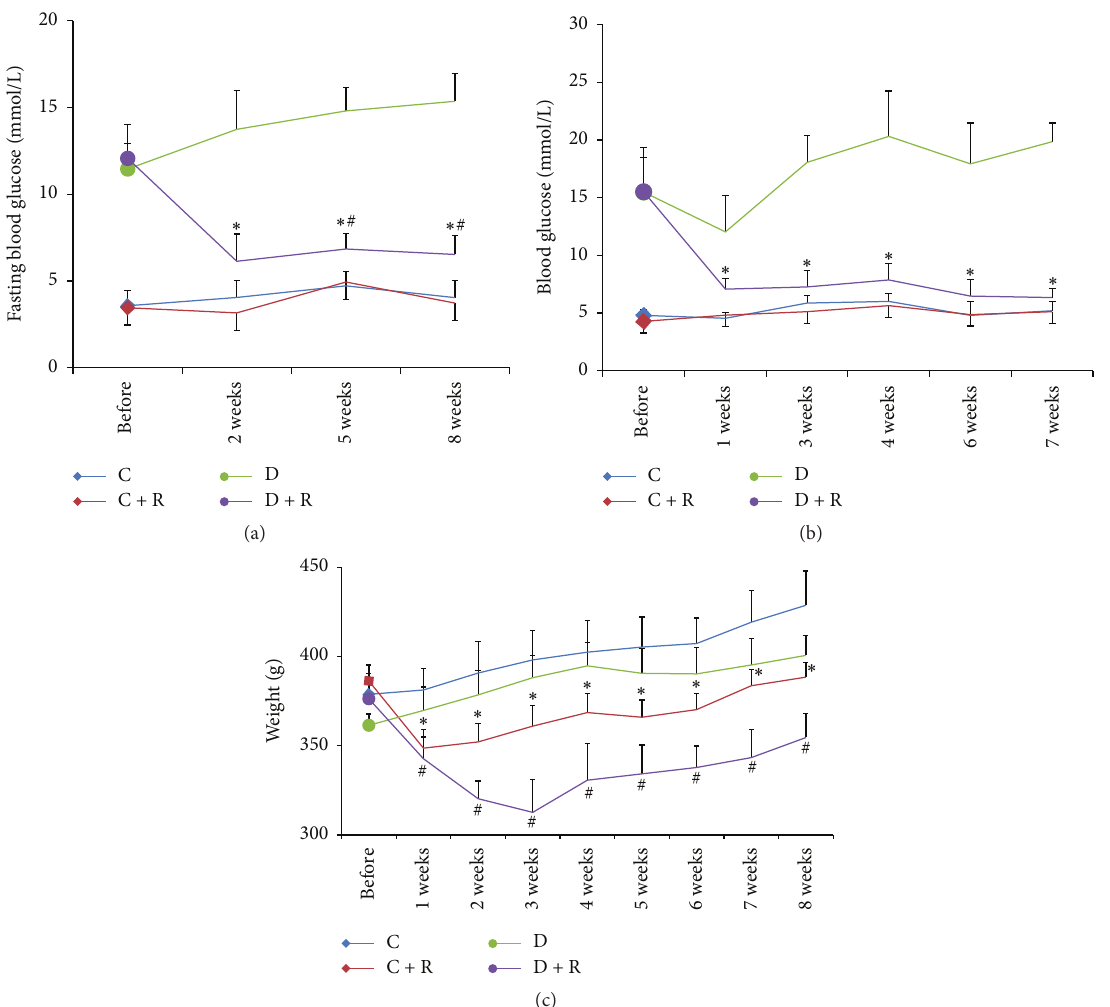
Figure 1: (a) Fasting blood glucose of four groups. ∗ 𝑃 < 0.01 compared with D group; # 𝑃 < 0.01 compared with C group. (b) Random blood glucose of four groups. ∗ 𝑃 < 0.01 compared with D group. (c) The change of weight in each study group was assessed before and every week after surgery. ∗ 𝑃 < 0.01 compared with C group; # 𝑃 < 0.01 compared with D group.